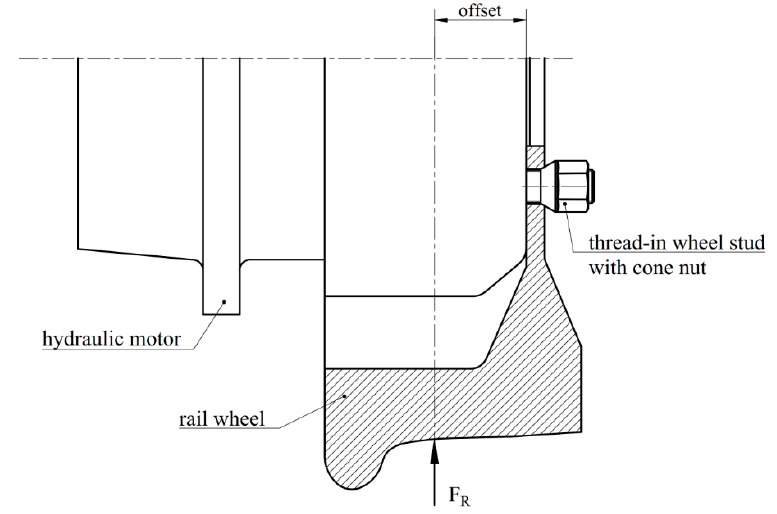
Figure 2. Assembly of rail wheel on hydraulic motor with drum brake.